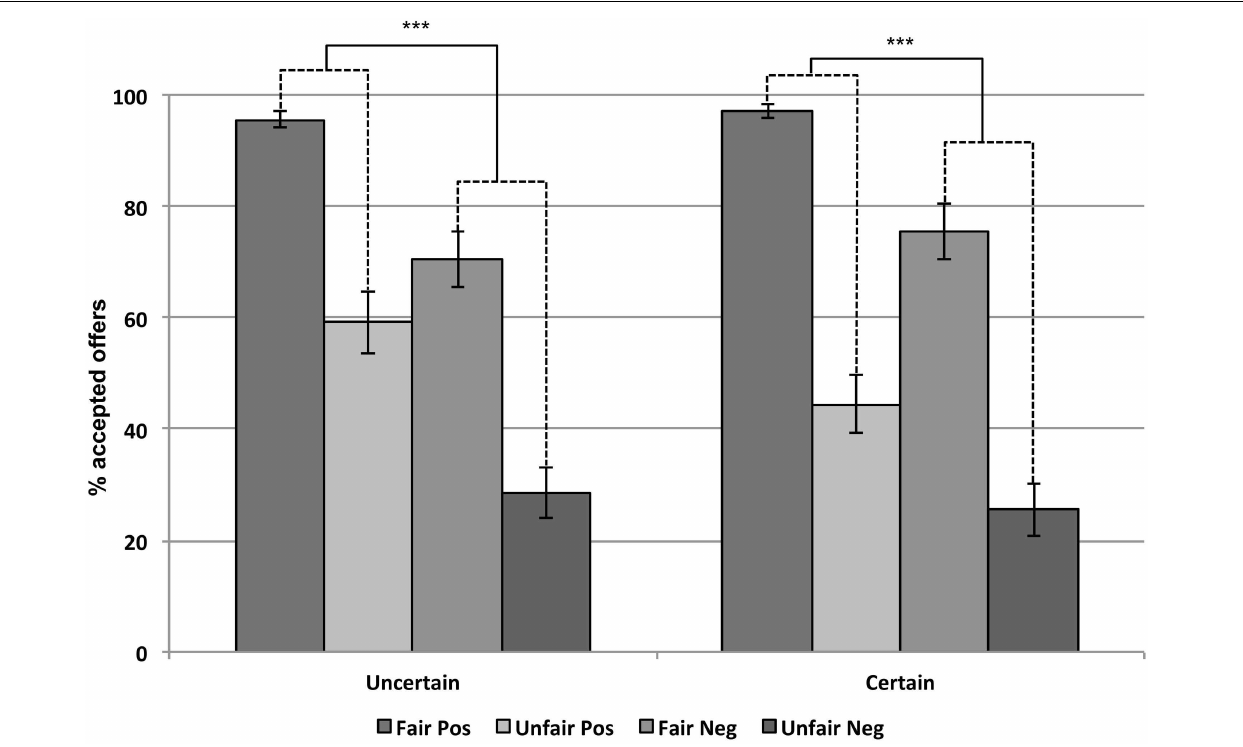
Error bars represent standard errors of the mean. Lines represent significant effects of the positive vs. negative valence of the trait-words (*** p <